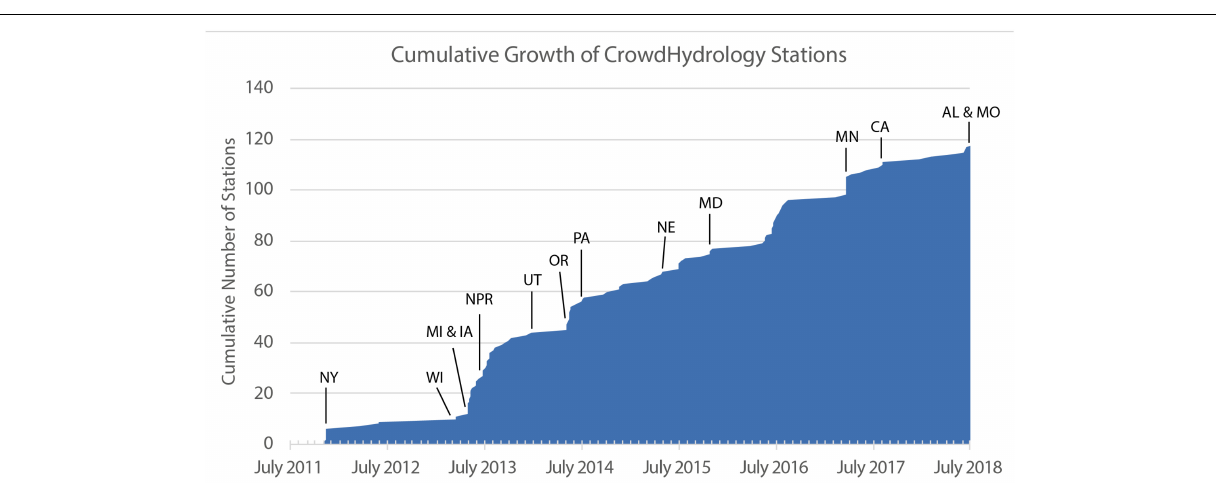
FIGURE 2 | Locations of CrowdHydrology gauges as of July 2018 with the size of the marker indicating the number of citizen science observations.